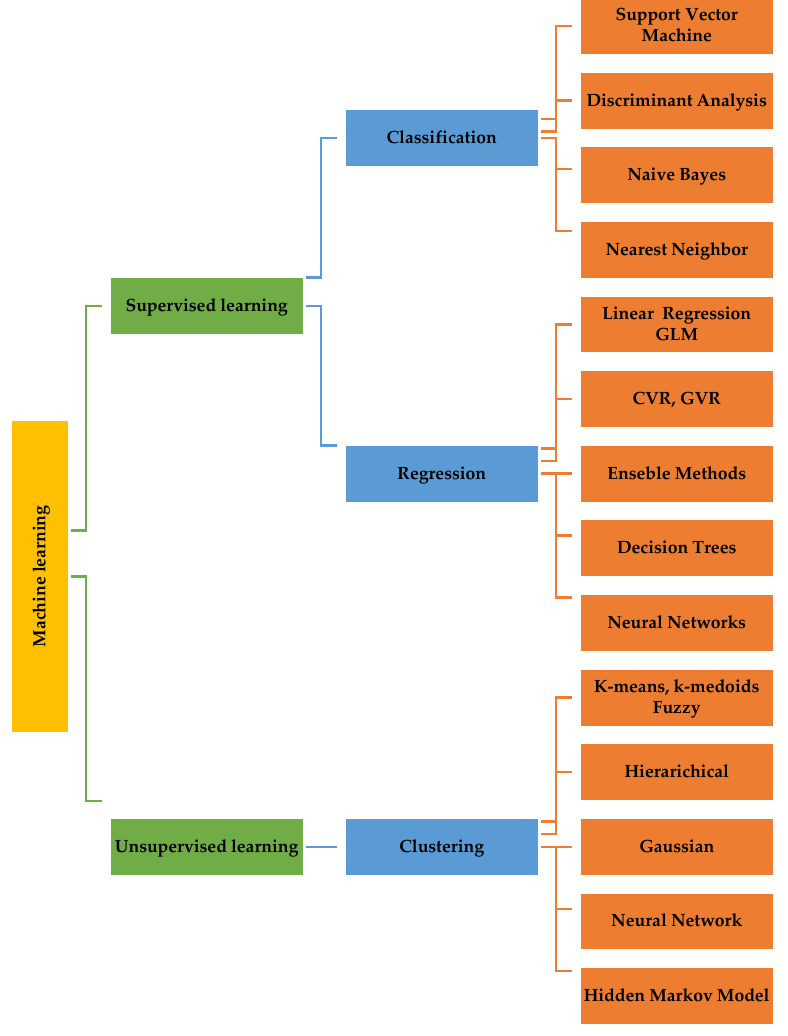
Figure 3. Steps involved in ML problems.